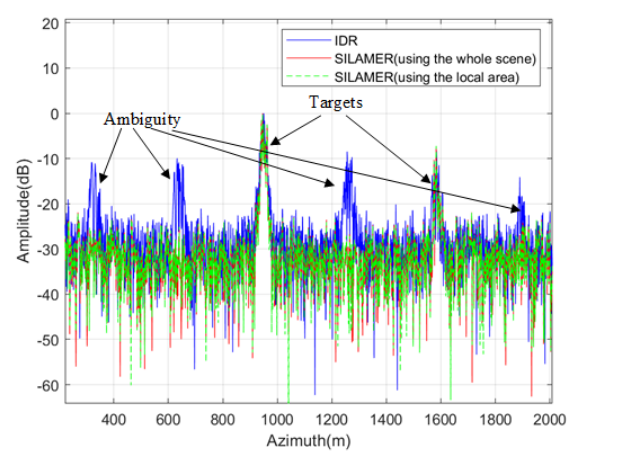
Figure 17. The azimuth profile of reconstruction results of the targets in Region A in Figure 16 by using IDR and